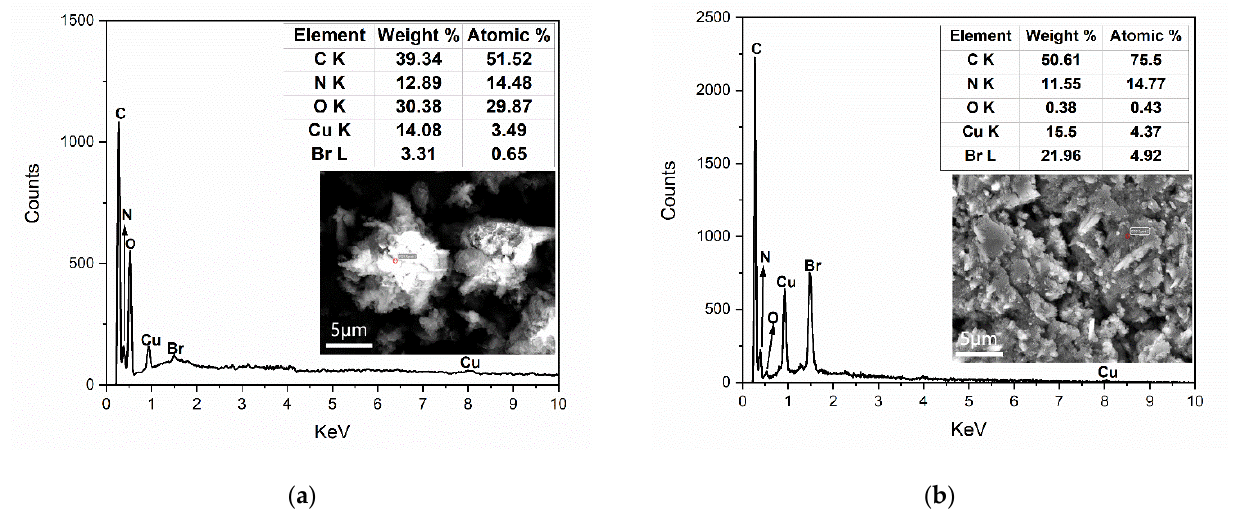
Figure 4. Energy dispersive spectroscopy of ( a ) CP, ( b ) CP-IL. The increase of the mass percentage of C and Br elements indicated that the IL was adsorbed on the